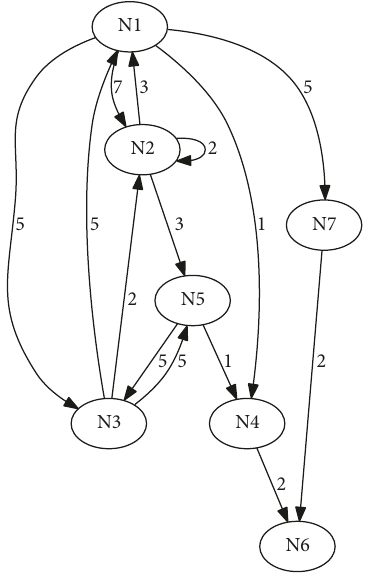
Figure 10: Graph configuration 1,160. Edge weights are shown next to the edges. Node 1 has weight 20, node 2 has weight 8, node 3 has weight 10, node 4 has weight 10, node 5 has weight 15, node 6 has weight 4, and node 7 has weight 8.